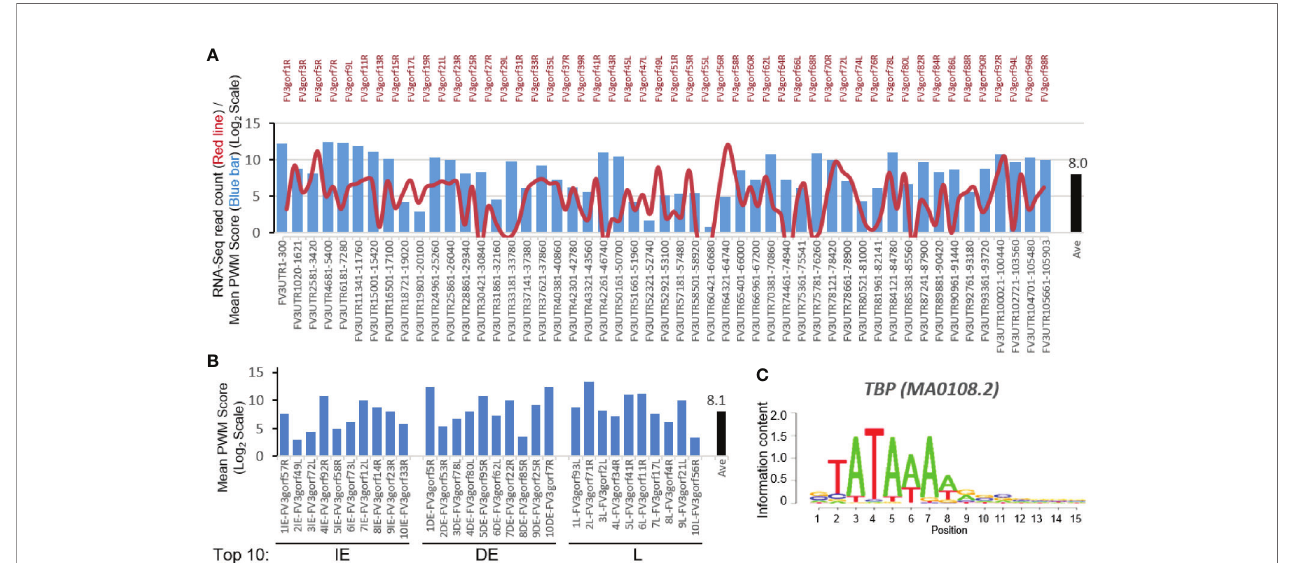
FIGURE 2 | Transcriptomic comparison and distribution of TATA-Box-like cis -element in intergenic regions of the FV3 genome. (A) Line chart depicts cross-tissue averages of RNA-Seq reads differentially mapped to intergenic regions and almost all annotated FV3 coding ORFs labeled on the top. Note the X-Axis tick labels on the top for even-numbered ORFs (such as FV3gorf2L between FV3gorf1R and FV3gorf3R) are omitted due to the space limitation. Bar chart depicts the position weight matrix (PWM) scores of the TATA-box, a cis -regulatory element (CRE) marking core promoters of eukaryotic genes signi fi cantly detected across all FV3- genome intergenic regions (labeled as FV3UTR start-end nt position along the FV3 reference genome). (B) Mean PWM scores of TATA-box CRE in FV3 intergenic regions that are intermediately upstream of top-ten highly expressed FV3 coding genes (ORFs) in each temporal class of immediate early (IE), delay early (DE), or late (L) genes as revealed by transcriptomic analyses. Mean PWM scores were calculated using tools at https://ccg.ep fl .ch/pwmtools/pwmscore.php. In both (A) and (B) , the cross-panel mPWM scores of the TATA-box CRE is averagely (Ave) shown as data-labeled black bar at the right. (C) The matrix of TATA-box that interacts with a transcription factor of TATA-box binding protein (TBP) is from MEME-derived JASPAR CORE 2020 vertebrates af fi liated with the PWM